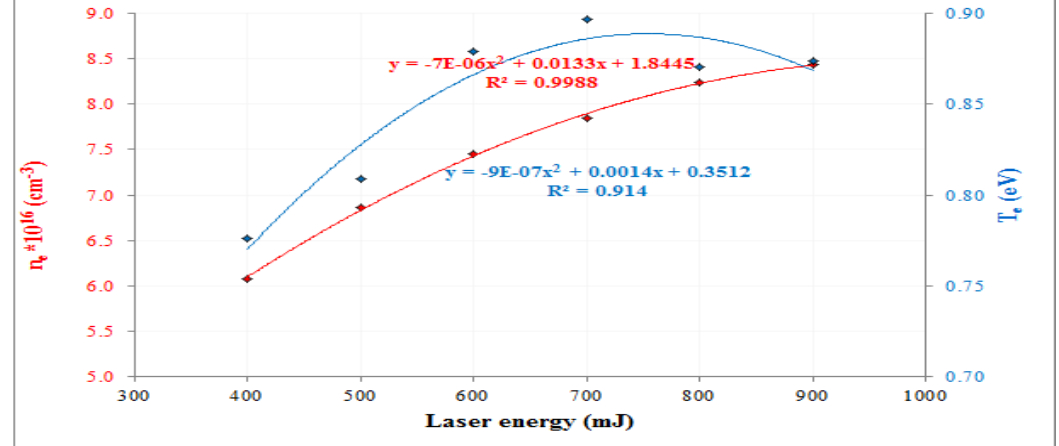
Fig.10: The variation of T